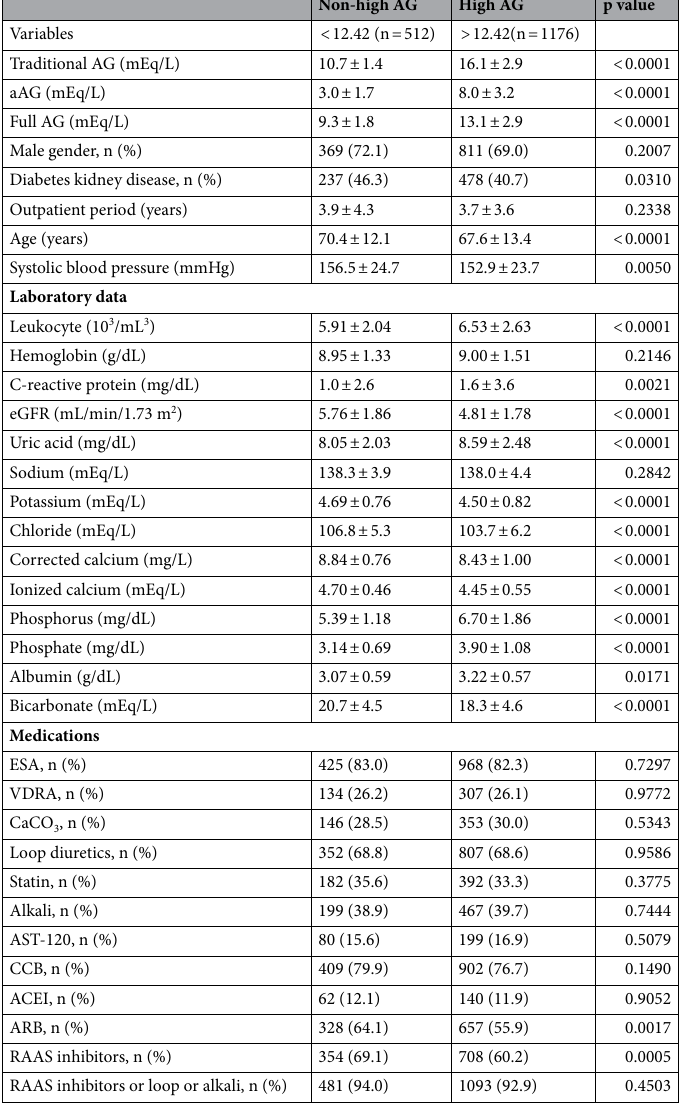
Table 3. Comparison of patient characteristics between the high (traditional) AG and non-high (traditional) AG groups. aAG albumin-adjusted